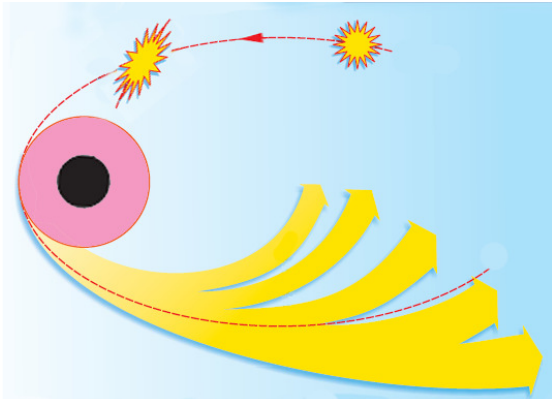
Figure 3. Conceptual illustration of tidal disruption of a fast-moving star by a massive rotating black hole (slicing along θ = 0 surface reveals “pink” ergosphere and “black” BH with its outer event-horizon) the star may be torn into pieces, some of which become captured, while others catapulted by BH (adapted from Reference